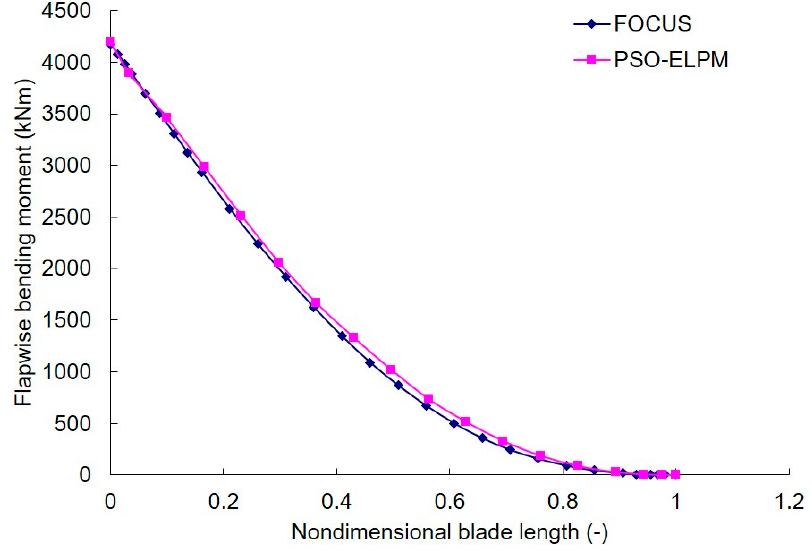
Figure 10. Comparison of extreme flapwise bending moment along the blade (1.5 MW).